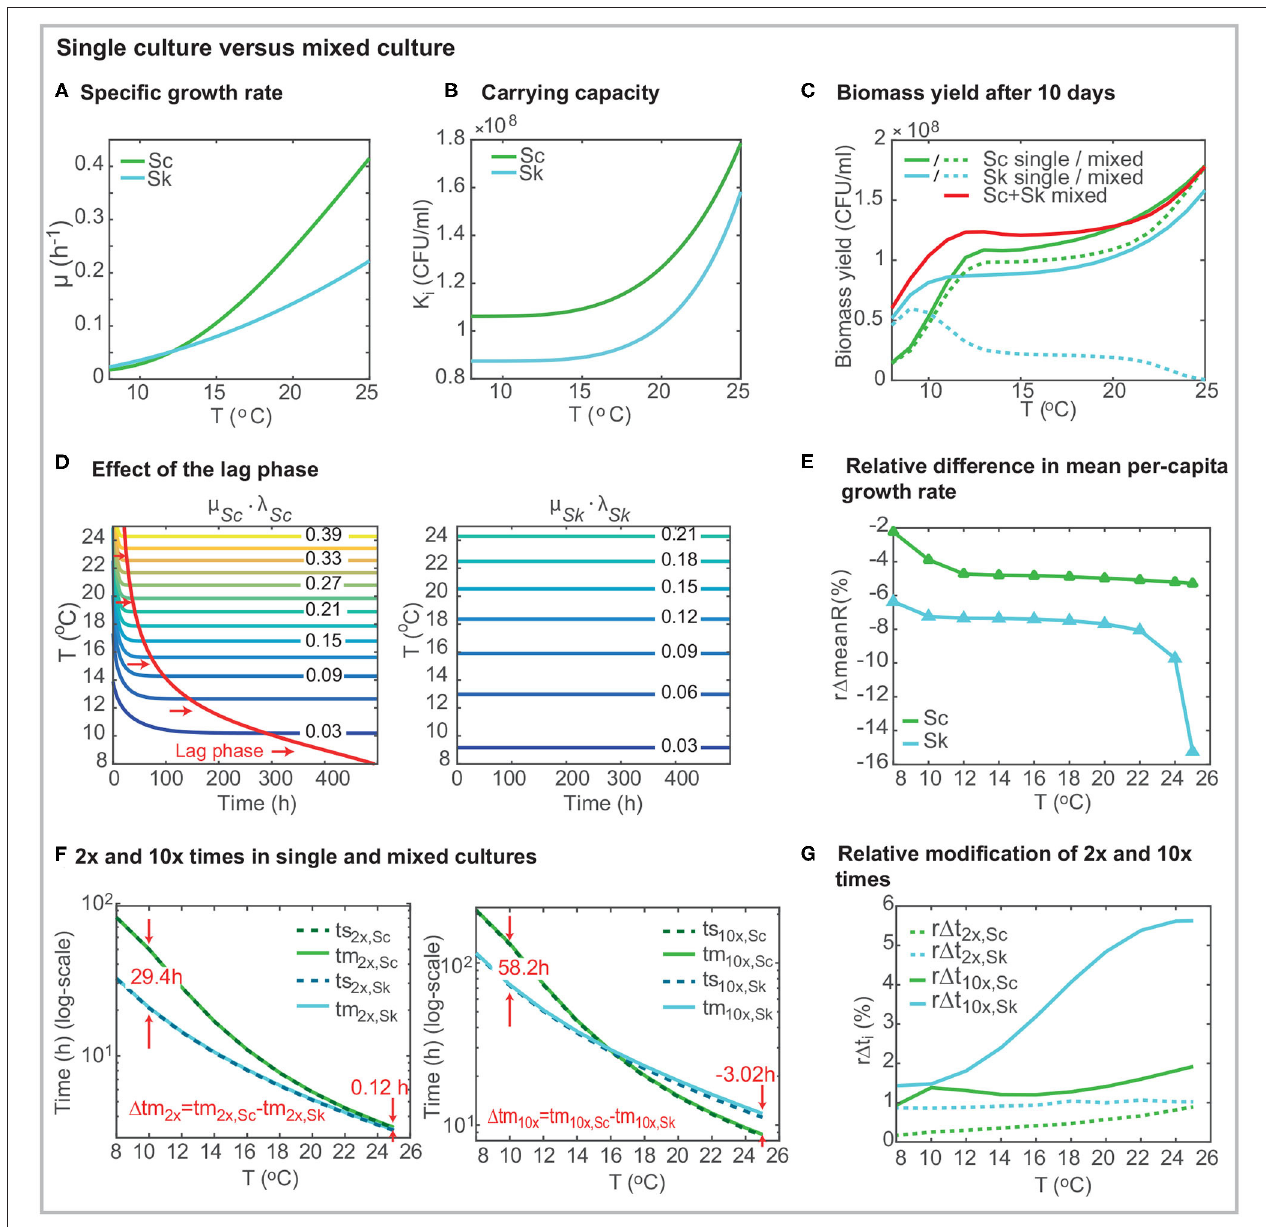
FIGURE 2 | Comparison of strain behavior in single and mixed cultures using the best model. (A) presents the specific growth rate µ i ( T ) as a function of the temperature for both strains. (B) shows the carrying capacity as a function of the temperature ( K i ( T )). (C) shows the biomass yield after 10 days in mixed co-inoculated (50/50) fermentations. (D) shows the effect of the lag-phase. In the case of S. cerevisiae , the time required to achieve the maximum specific growth rate depends on the temperature. The lag-phase is significantly longer at lower temperatures. (E) presents the relative decrease of the mean per-capita growth rate (over time) in mixed culture. The per-capita growth rate for Sk in mixed cultures ( R m , Sk ) is up to a 15.4 % lower than its value in single culture ( R s , Sk ). For the case of Sc , the effect of temperature on the per-capita growth rate is higher than the presence of another cell. (F) presents the 2x and 10x times for single and mixed cultures. (G) shows the relative increase in 2 x and 10 x times in mixed culture. The presence of Sc has a significant effect on the 10 x time for Sk . Figures were obtained for a 2 × 10 6 ( CFU / ml ), 50 % of each species (50/50).